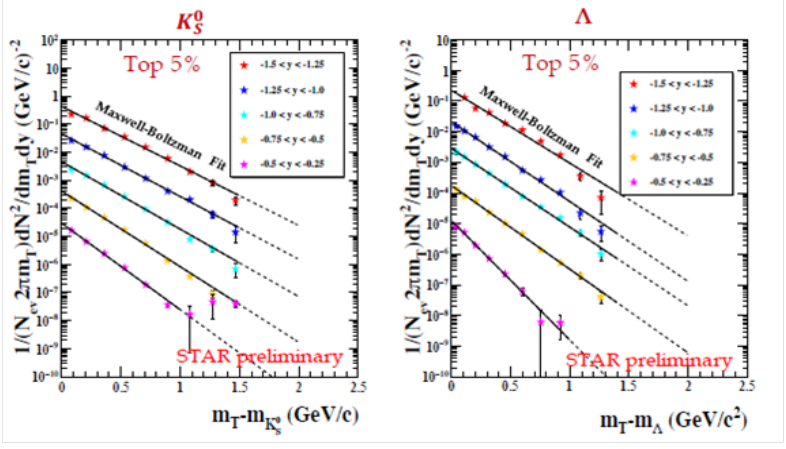
Figure 7. Spectra of strange particles obtained in the fixed-target mode as a function of transverse kinetic energy. Left : Spectra of K 0 . Right : Spectra of Λ S